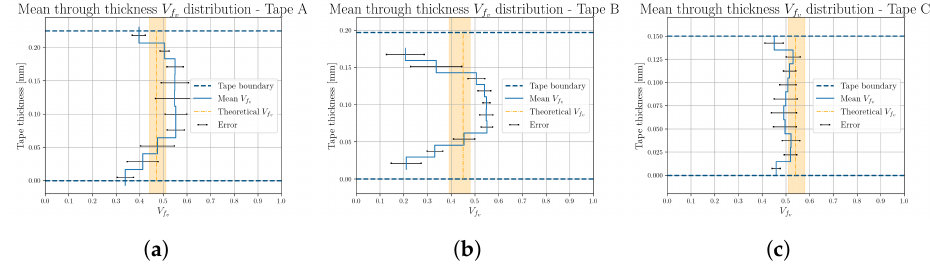
Figure 13. Through thickness analyses V f